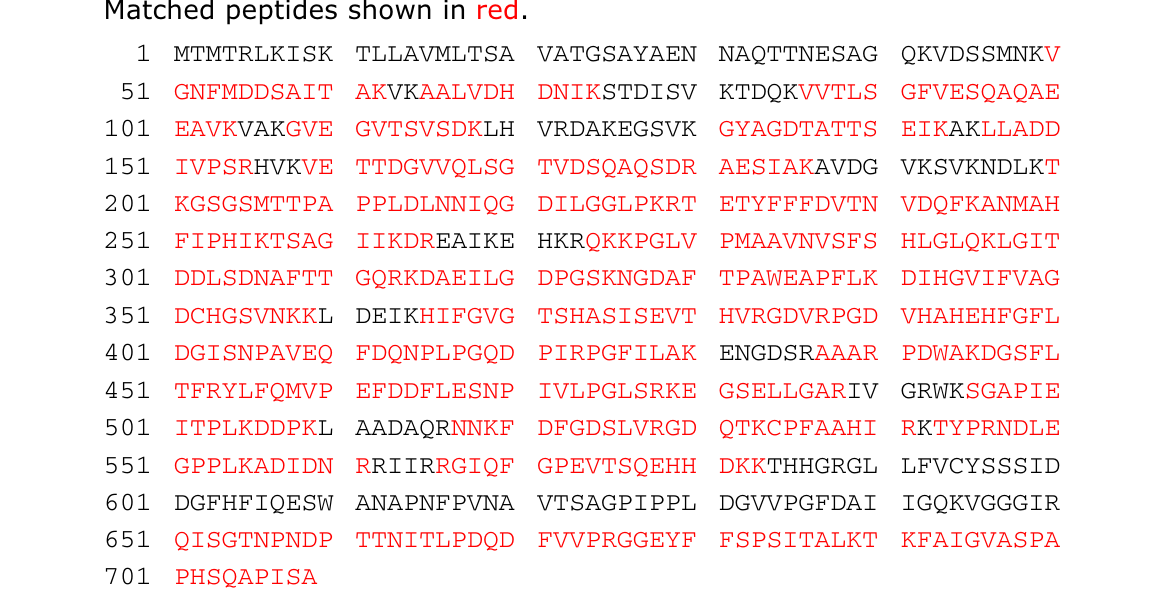
Fig. 6 Mass spectrometry data of SEC fractions F2 ( a ) and F7 ( b ) proteins. Mascot database searching against the Escherichia coli (strain B/BL21‑DE3) reference proteome, plus the recombinant OsmY‑DyP4 sequence, led to matching to this recombinant protein. Matched peptides are shown in red against the full‑length amino acid sequence of the recombinant